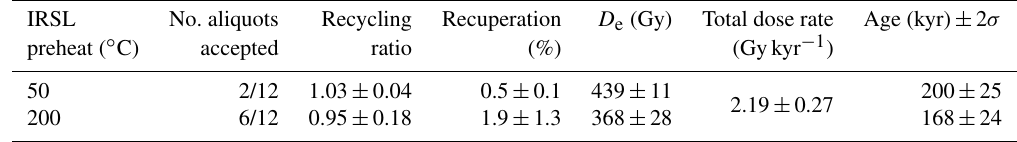
Table B2. Results for the coarse-grained sample L20 (A0113) of different IRSL preheat temperatures. IRSL No. aliquots Recycling Recuperation D e (Gy) Total dose rate Age (kyr) ± 2 σ preheat ( ◦ C)